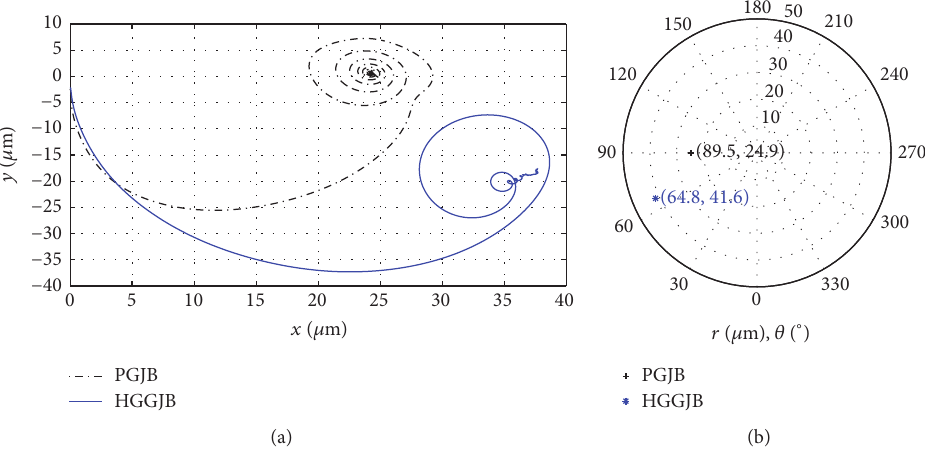
Figure 12: (a) Rotor trajectory and (b) polar coordinates of the HGGJB and PGJB at the rotating speed of 10000r/min.